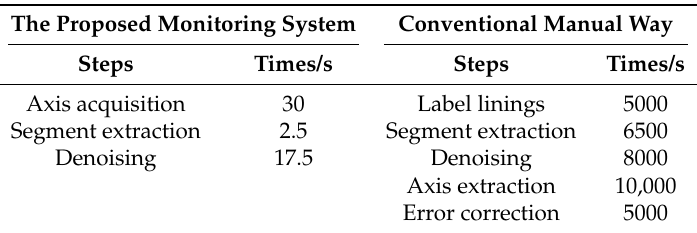
Table 1. Comparison of post-processing time between the two